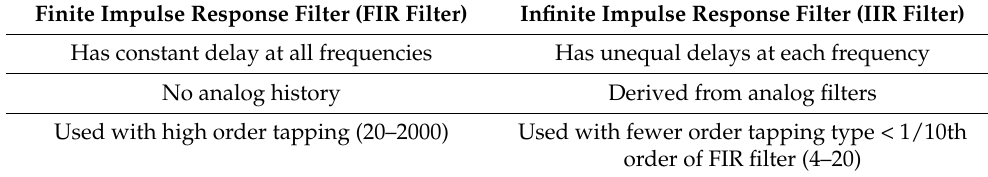
Table 1. Cont. Finite Impulse Response Filter (FIR